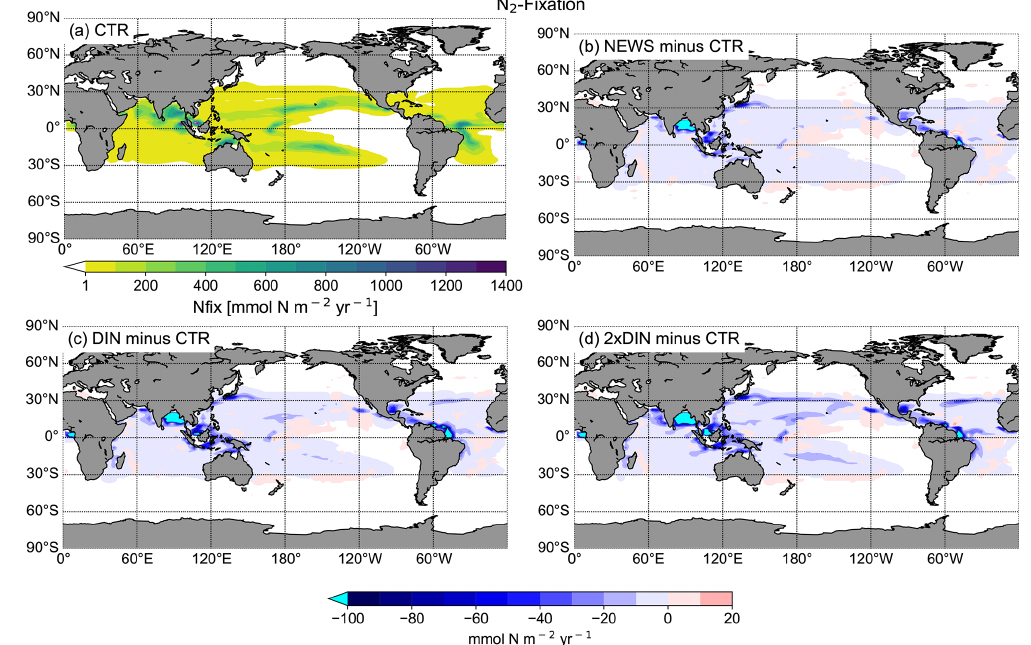
Figure 8. (a) Global distribution of N 2 fixation in CTR in mmolNm − 2 yr − 1 . The white areas show regions where rates are smaller than 1mmolNm − 2 yr − 1 . (b) Difference in annual vertically integrated rates of N 2 fixation calculated from UVic NEWS and CTR in mmolNm − 2 yr − 1 . (c) Difference in N 2 fixation in the simulation with riverine DIN and DON. (d) Difference in N 2 fixation in the simula- tion with twice the amount of DIN. The white areas show regions where differences are smaller than 0.01mmolNm − 2 yr − 1 . Local minima can be found near the Amazon River basin (from − 356mmolNm − 2 yr − 1 in NEWS − CTR to − 382mmolNm − 2 yr − 1 in DIN − CTR), in the Bay of Bengal (from − 347 to − 646mmolNm − 2 yr − 1 in 2 × DIN − CTR), and in the Gulf of Guinea (from − 180mmolNm − 2 yr − 1 in NEWS − CTR to − 303mmolNm − 2 yr − 1 in 2 × DIN −